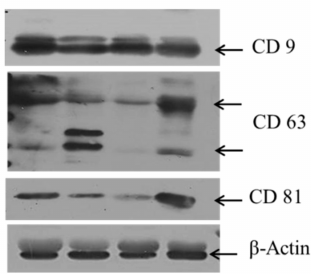
Figure 1. Expression of exosome-associated markers (CD9, CD63, and CD81).